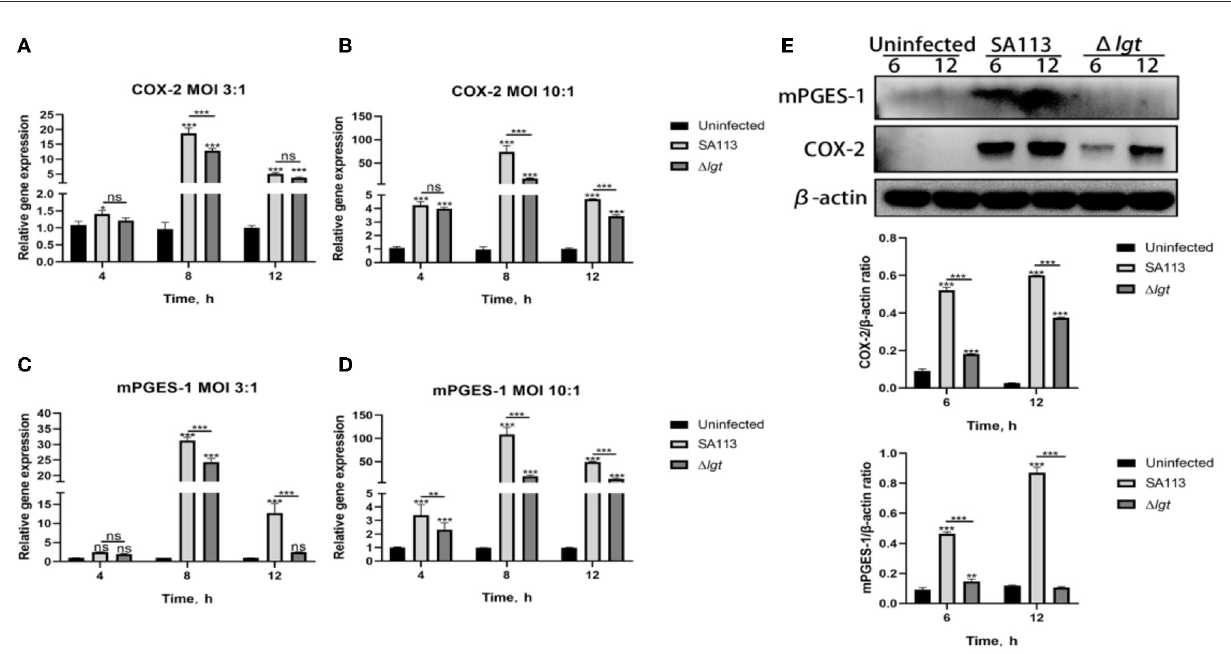
FIGURE2 COX-2 and mPGES-1 expressions were induced by S. aureus lipoprotein. mRNA expression of COX-2 and mPGES-1 at 4h, 8h, and 12h was detected by qRT-PCR [MOI 3:1 and MOI 10:1; (A–D) ]. The protein expression of COX-2 and mPGES-1 was detected by Western blot at 6h and 12h